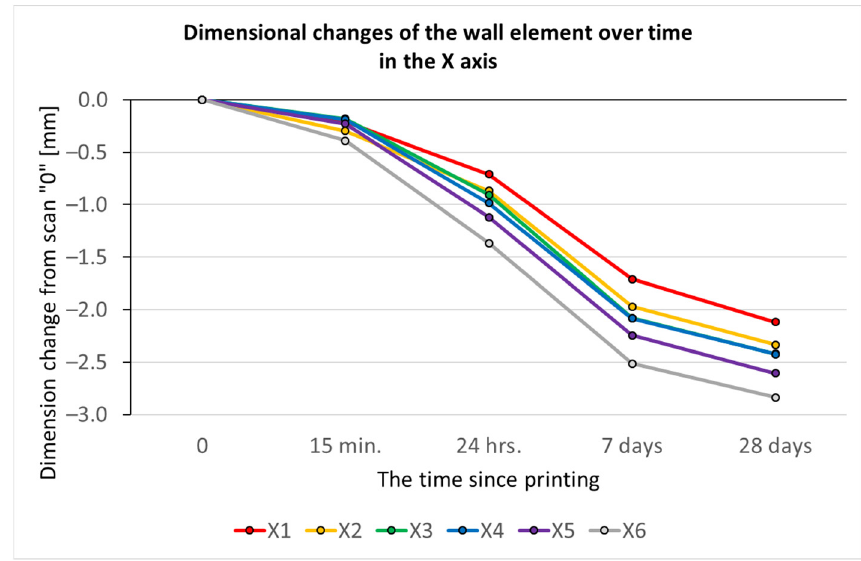
Figure 13. Dimensional changes of the wall element over time in the X ‐ axis (based on local Caliper measurements).